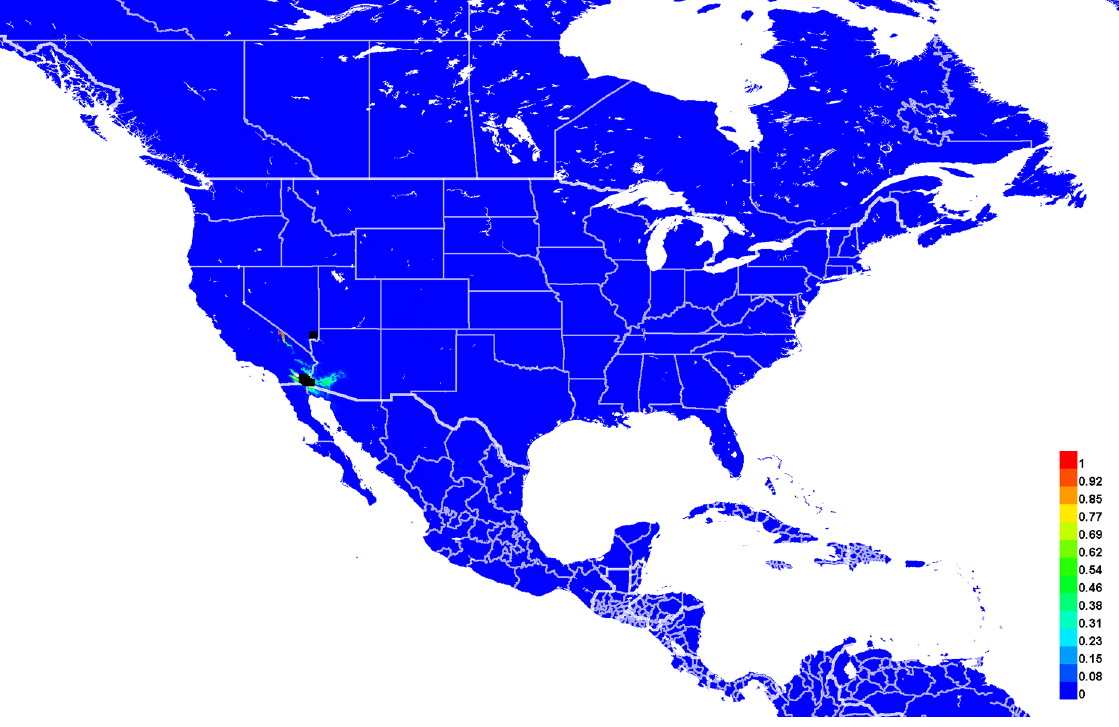
Fig. 77. Georeferenced collection records of Lasioglossum ( D. ) rufornatum sp. nov. (black squares) and predicted distribution by maximum entropy ecological niche modeling in Maxent (colour shading). Warmer colours indicate higher cloglog probability of